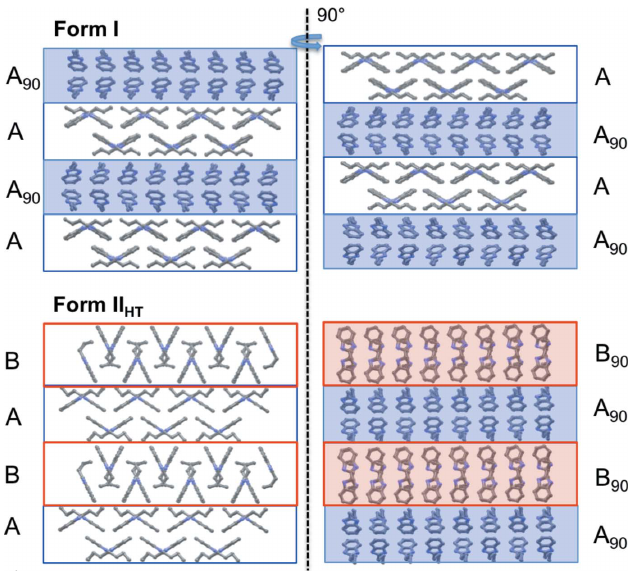
Figure 9 Illustration of the structural similarities and differences between form I (top) and one of the disordered configurations in II HT (bottom). Type A layers are blue and type B layers are red. Form I (top): view along the a axis (left) and the b axis (right). Form II HT (bottom): view along the c axis (left) and the a axis (right).